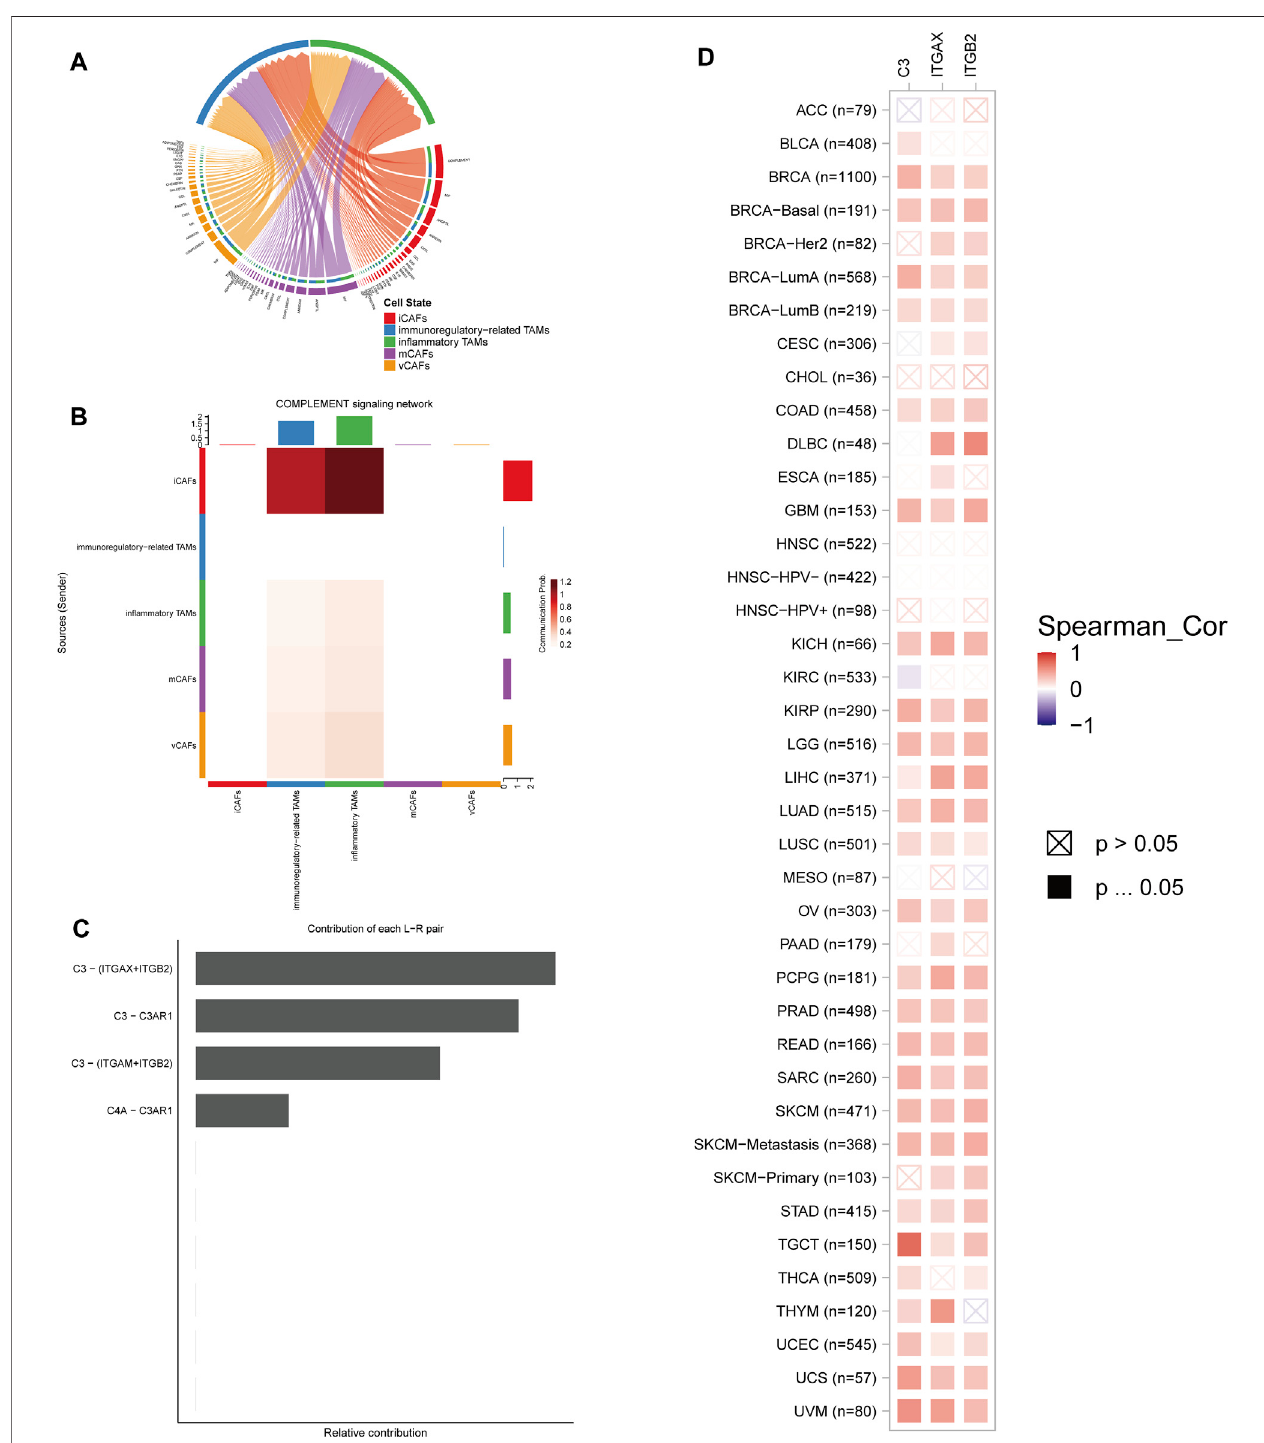
FIGURE 7 | The complement signal network was highly activated between iCAFs and in fl ammatory TAMs. (A) Communication signals sent from CAFs and targeting TAMs. (B) Complement signaling network was highly activated between the in fl ammatory phenotypes of CAFs and TAMs. (C) Contribution of each LR pair of complement signal to the network. (D) Pan-cancer correlation between the expression of JUNB and C3-(ITGAX + ITGB2).